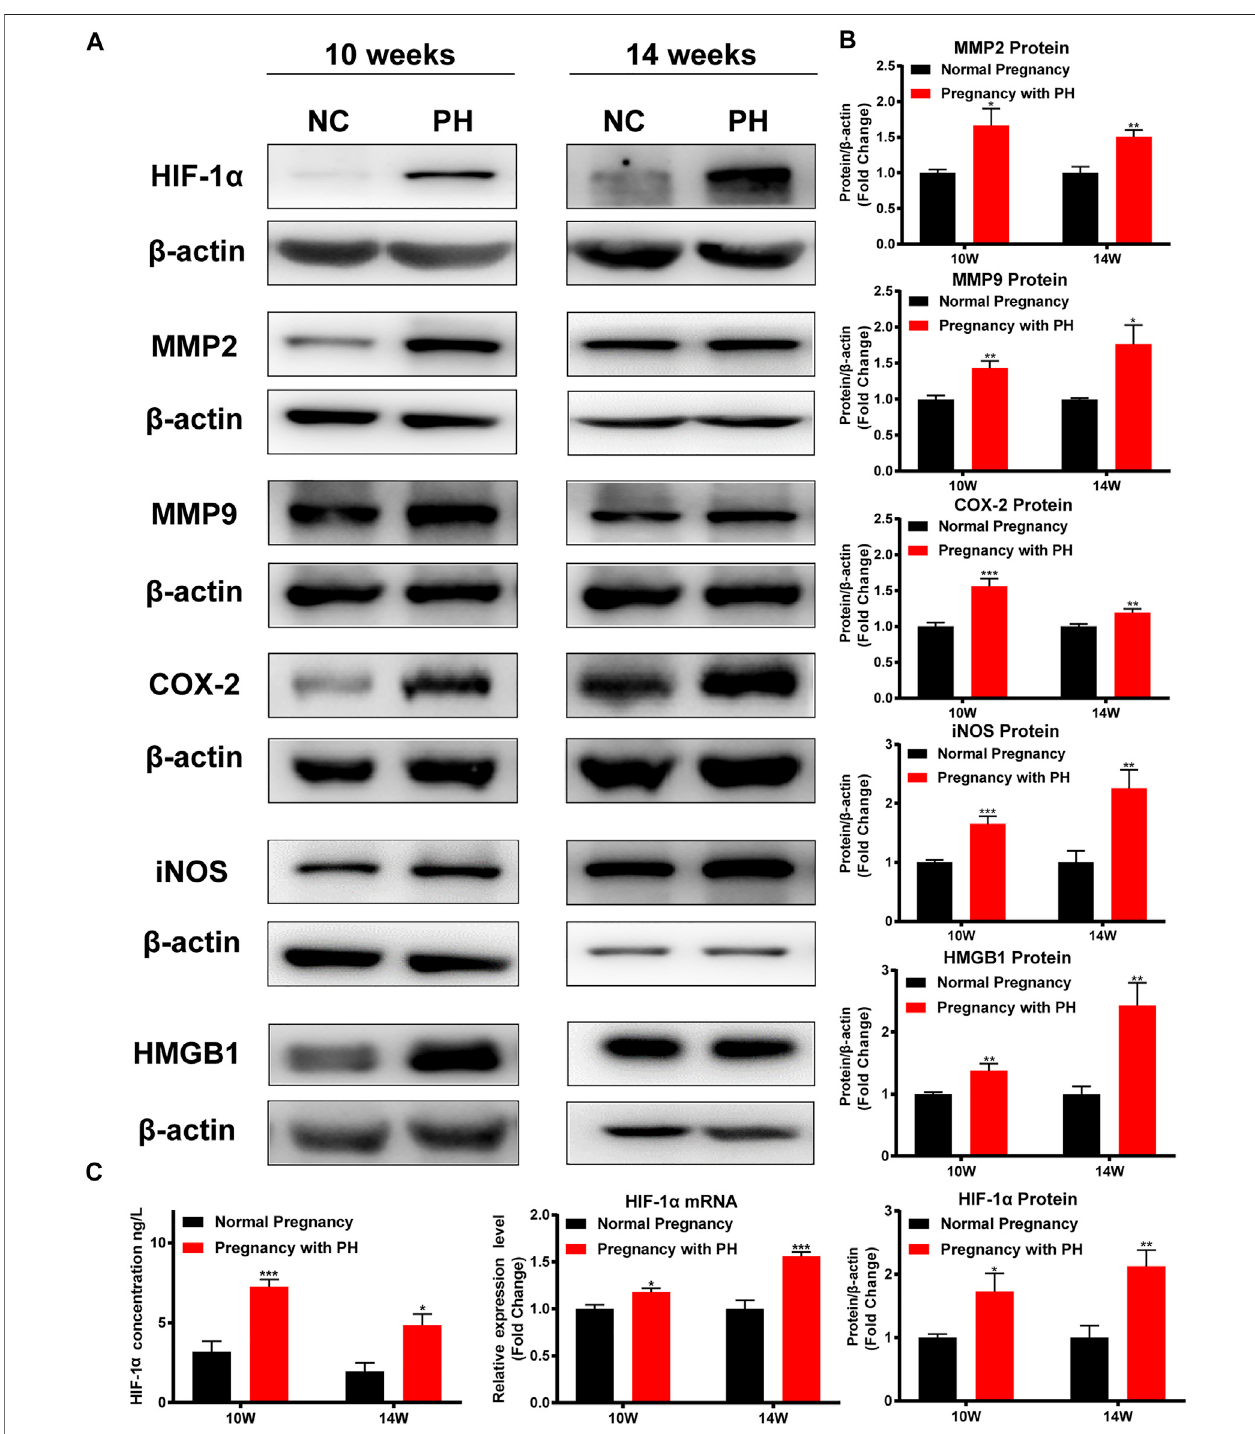
FIGURE7| Cerebralhypoxiaandin fl ammation existedintheadultratoffspringofthePHgroup. (A) WesternblotanalysisofHIF-1 α ,MMP2,MMP9,COX-2,iNOS, and HMGB1in thecerebralcortexofoffspring in each group at different ages. (B) Summaryofthe datashown in (A) . (C) The expression ofHIF-1 α inthe cerebral cortex of offspring in each group detected by ELISA, RT – qPCR, and Western blot analysis. * p < 0.05, ** p < 0.01, *** p < 0.001 vs the normal pregnancy group ( n (cid:1) 6 rats per group). NC, normal control; PH, pulmonary hypertension.